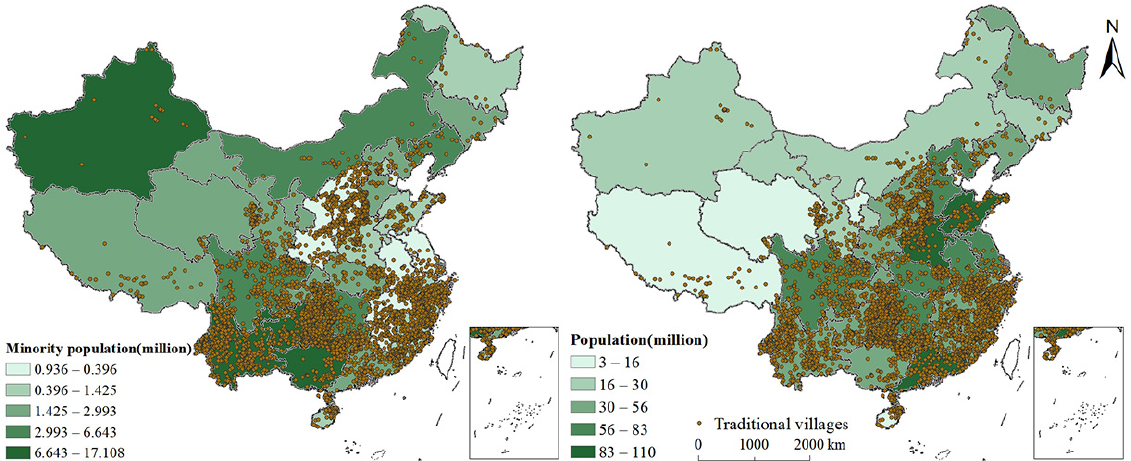
Figure 6. Spatial relationships between the distribution of traditional villages and population. Distance from Central